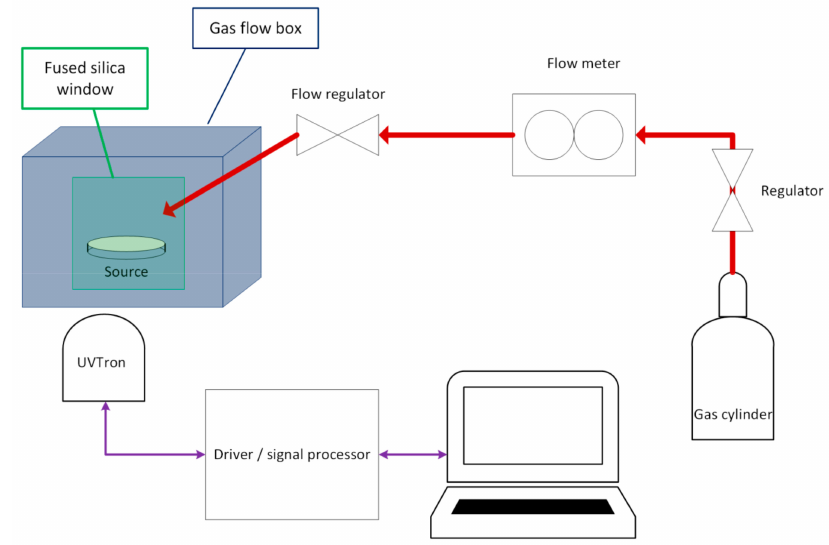
Figure 2. Schematic of equipment set